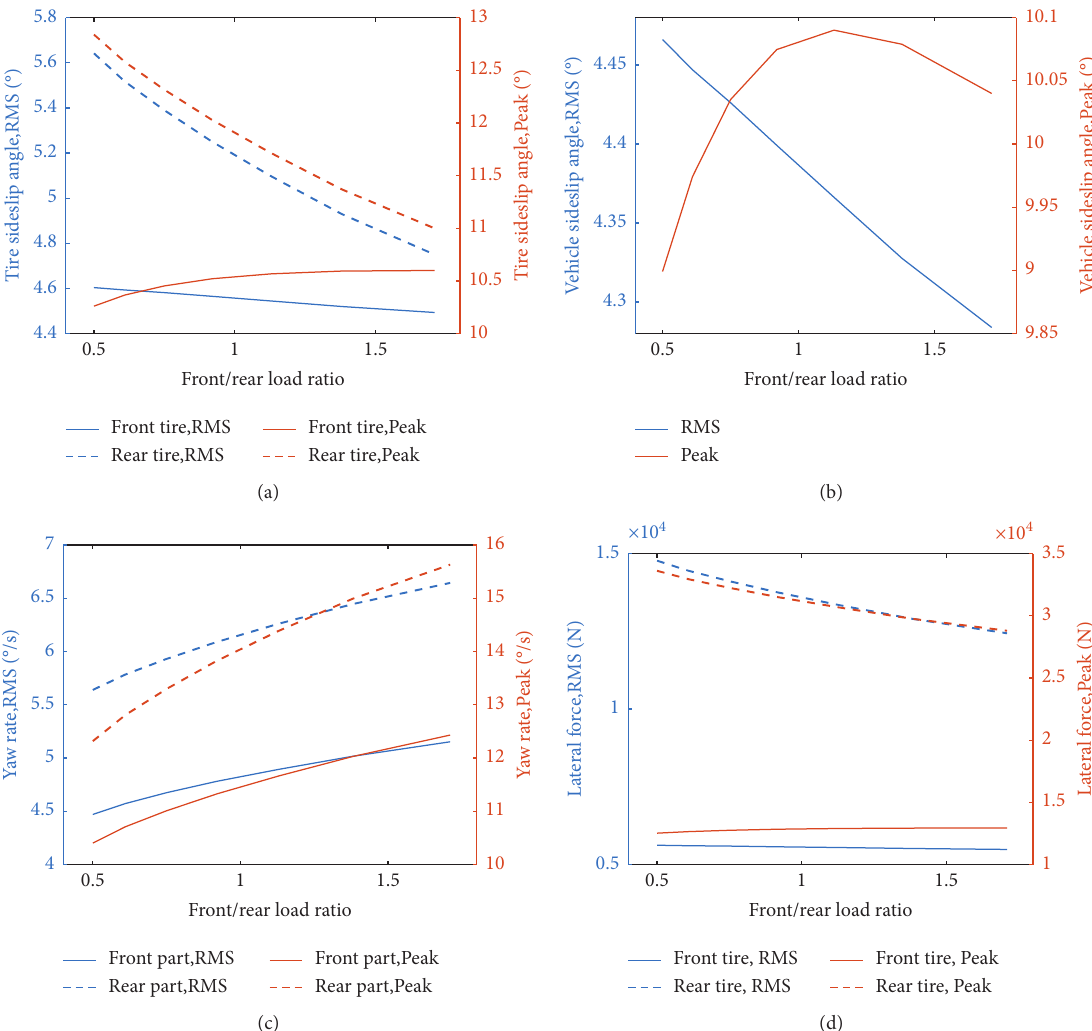
Figure 11: Vehicle performance of the load ratio variation. (a) RMS and peak value of tire sideslip angle. (b) RMS and peak value of vehicle sideslip angle. (c) RMS and peak vehicle yaw rate. (d) RMS and peak value of lateral